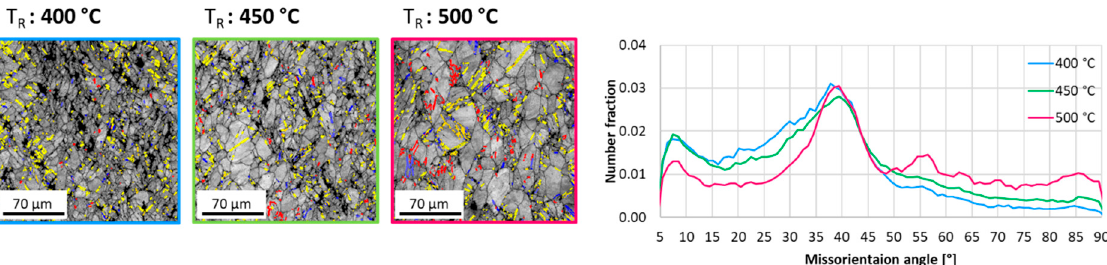
Figure 6. Indexing of the twin boundaries (compression twins (blue), tension twins (red), double twins (yellow)) in the sections from EBSD measurements and misorientation angle distribution of the as-rolled sheets.